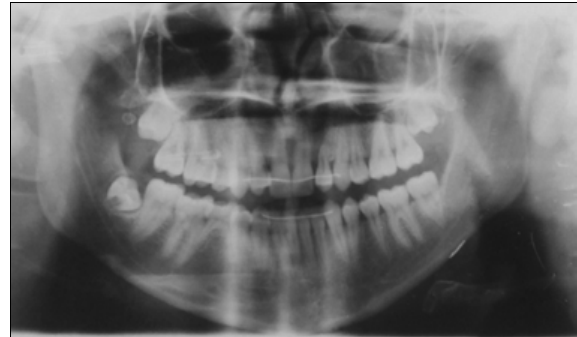
Figure 11. Post-treatment panoramic radiograph.